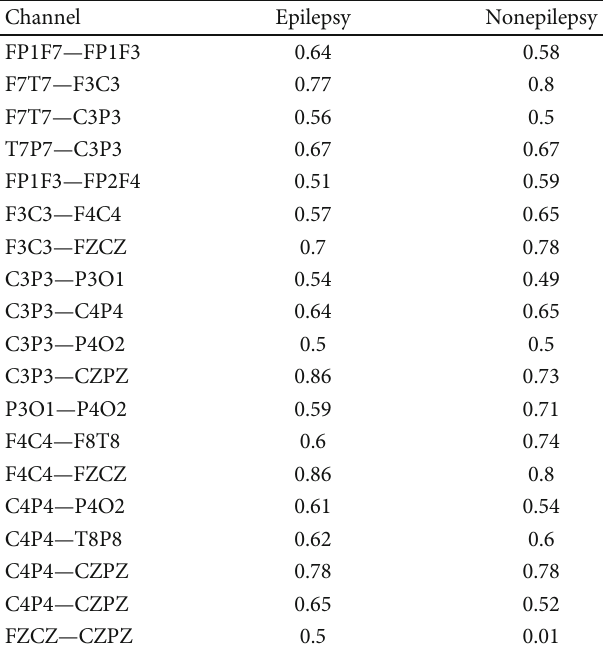
Table 1: Pearson correlation coe ffi cient of 2 channels ( > 0.5).